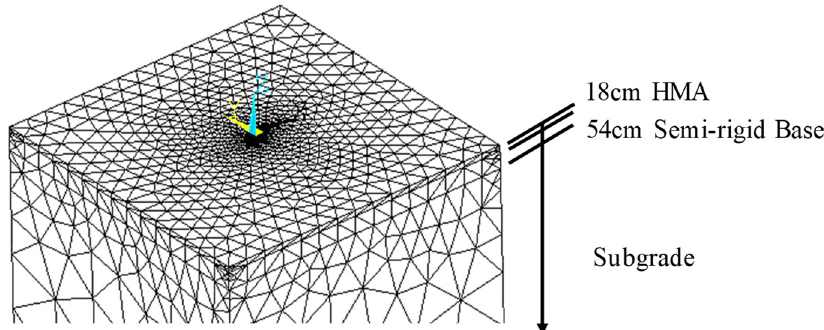
Figure 4. 3D Finite element model of the anisotropic asphalt pavement.